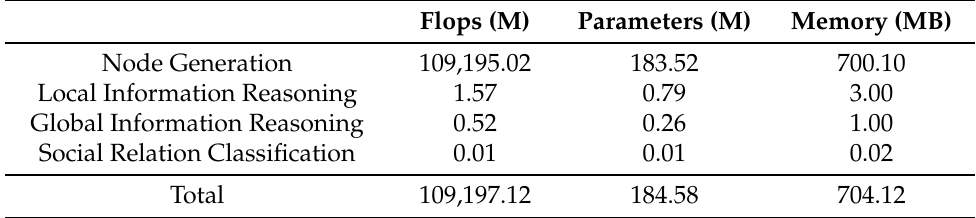
Table 6. The computational complexity of different modules of our model, i.e., the node generation module, the local information reasoning module, the global information reasoning module and the final social relation classification